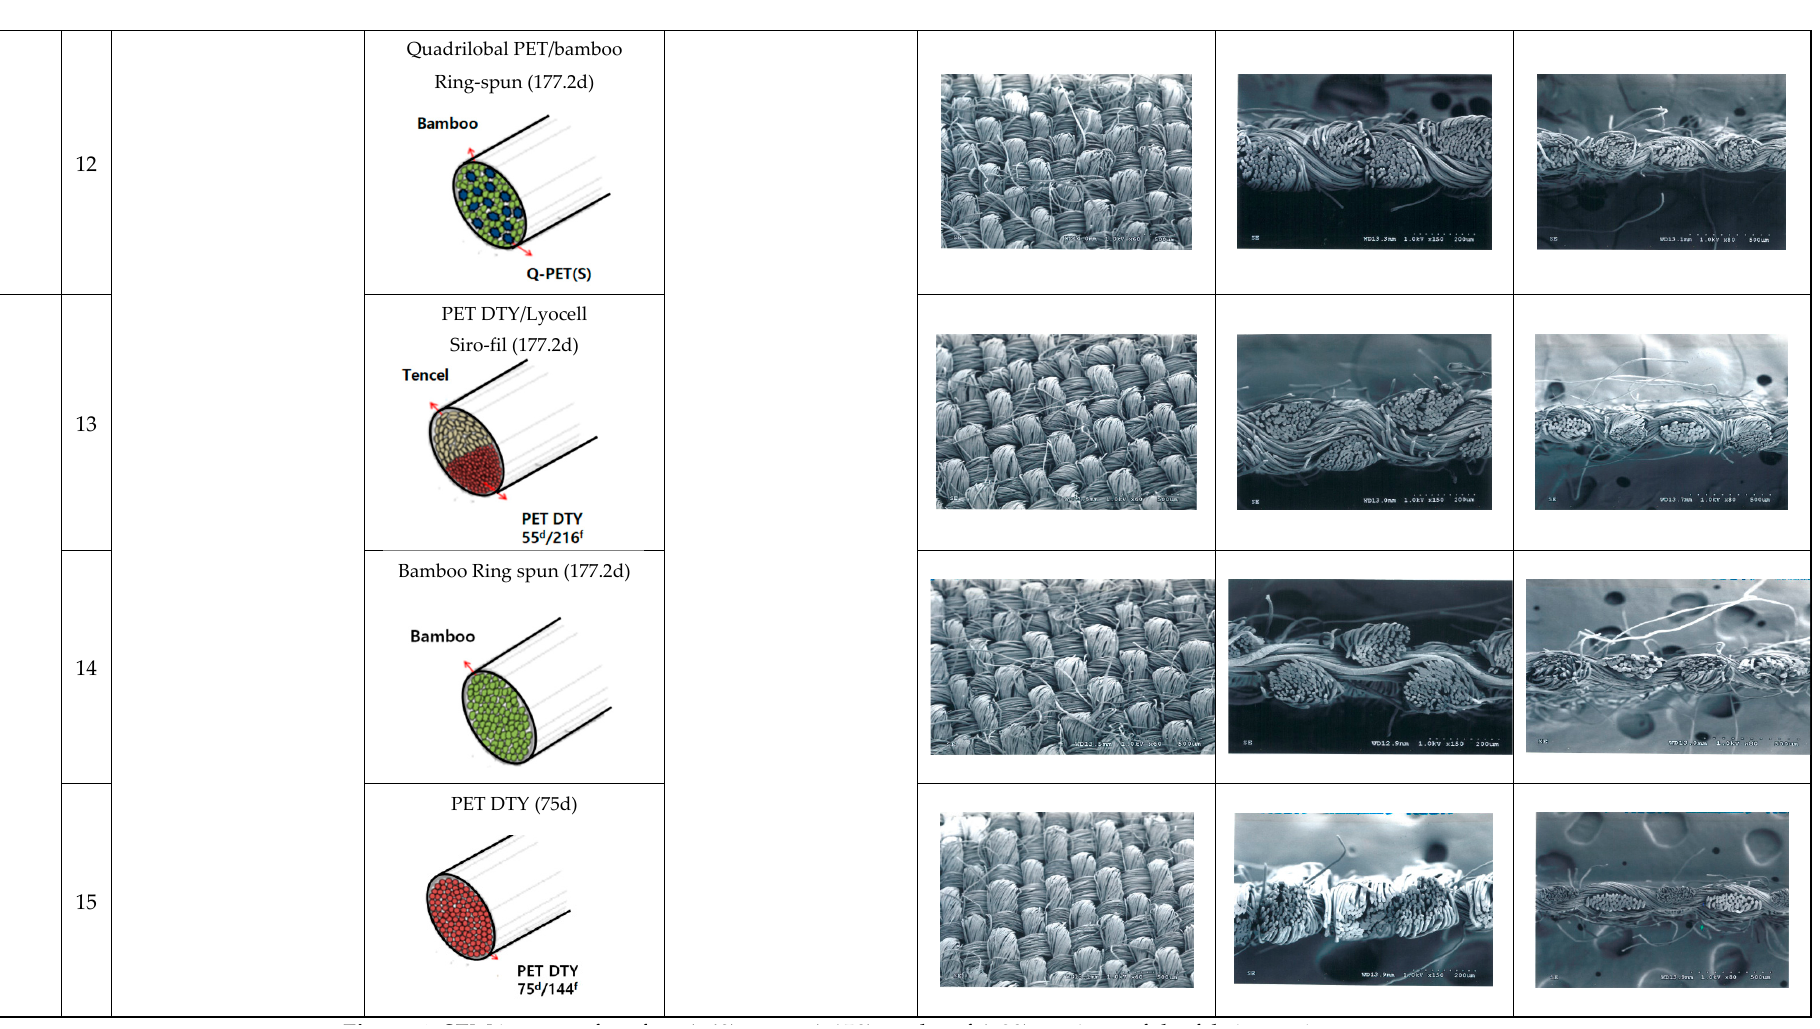
Figure 1. SEM images of surface (×60), warp (×150), and weft(×80) sections of the fabric specimens.